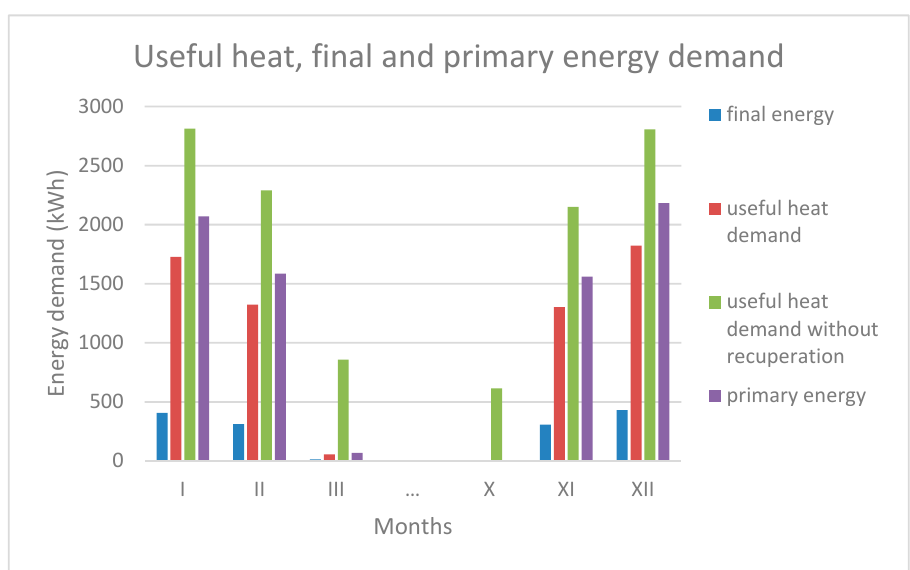
Figure 9. Monthly final and primary energy consumption and energy demand for space heating (bars for ventilation with heat recuperation and without are shown).